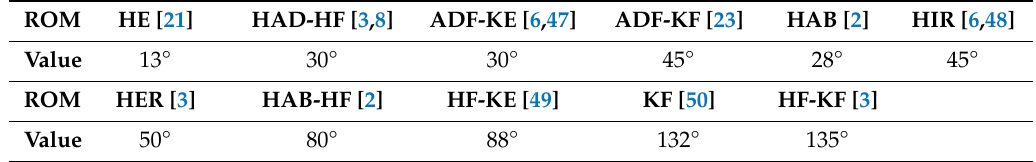
Table 2. Published cuto ff reference values used to identify muscle tightness. ROM